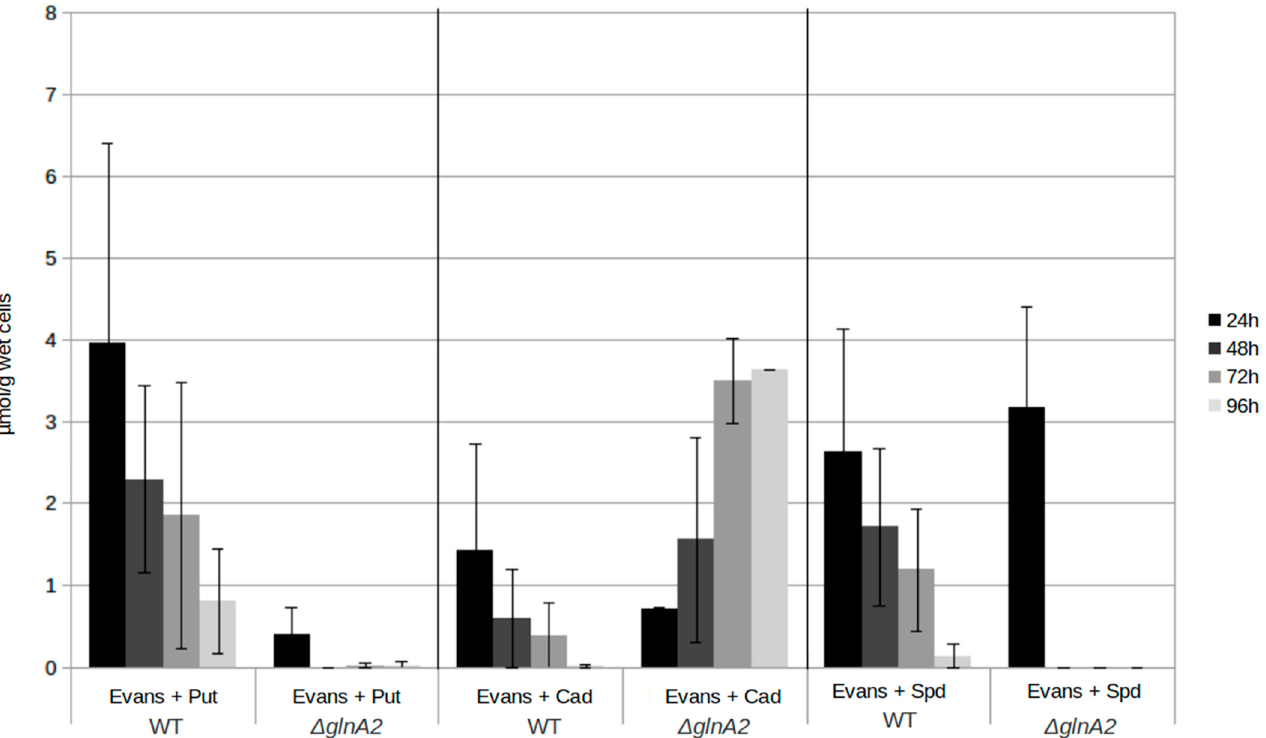
Figure 7. Intracellular polyamine concentration in S. coelicolor strains. The polyamine level of the ∆ glnA2 mutant and parental strain S. coelicolor M145 was monitored in samples taken after 24, 48, 72, and 96 h of cultivation in defined Evans medium supplemented with polyamines (Put—putrescine; Cad—cadaverine, or Spd—spermidine, 25 mM of each) as a sole nitrogen source. The mean value of three biological replicates was calculated in µmol per 1 g of wet cells. Error bars indicate standard error of two biological replicates.